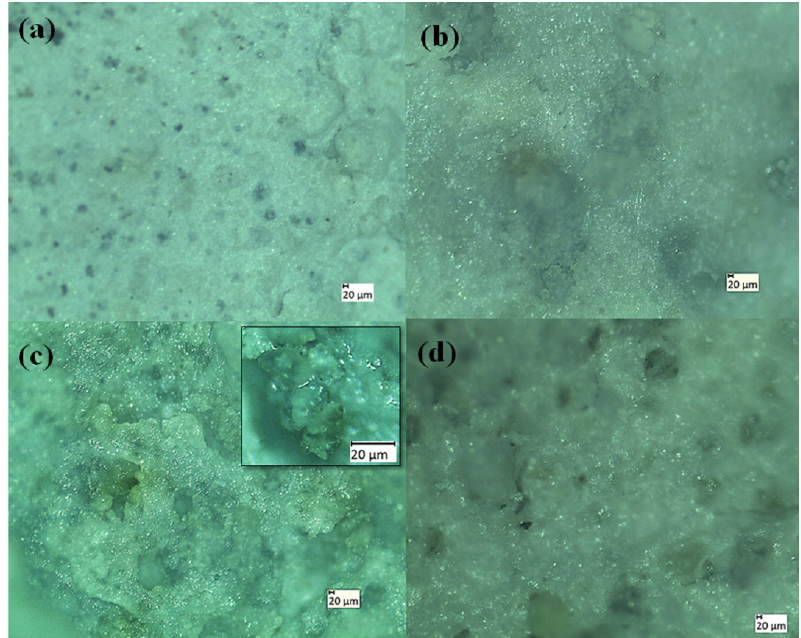
Figure 5. Optical micrographs of ( a ) HA, ( b ) TaHA, ( c ) SrHA (inset image is taken at higher magnification), and ( d ) SrTaHA.